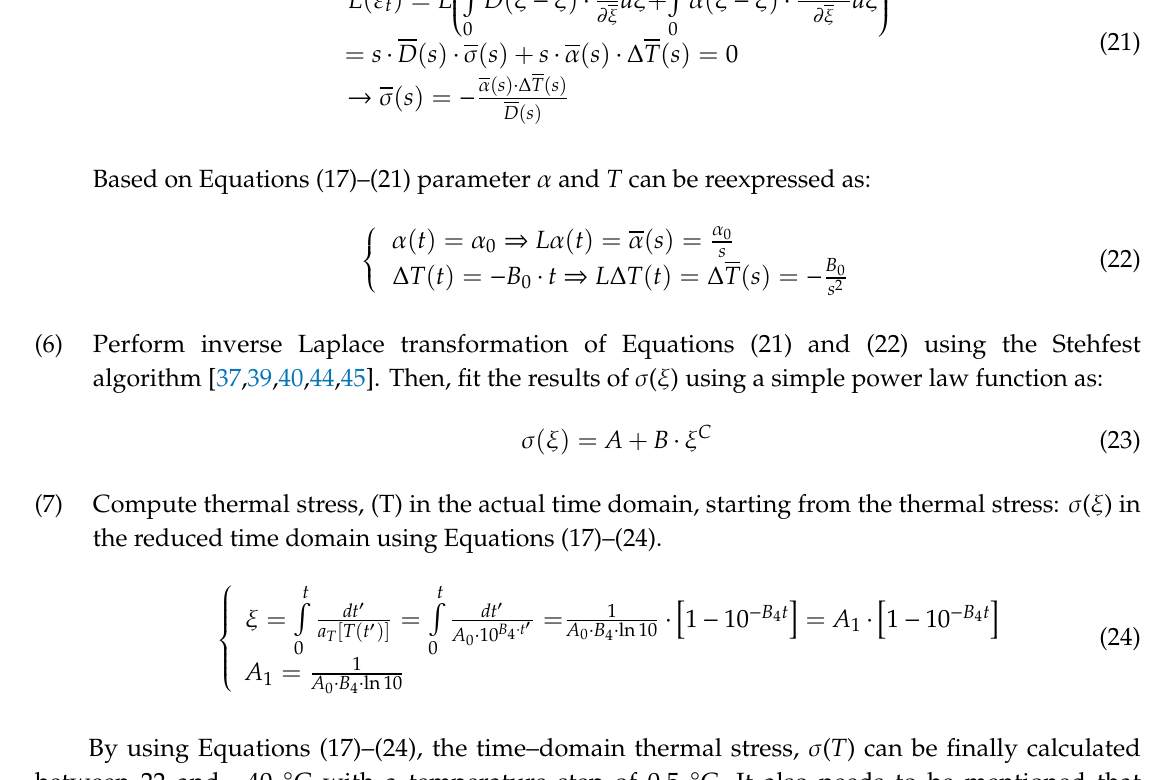
( a ) ( b ) Figure 6. m -value, m ( t ), at different testing time. ( a ) T = − 12 °C; ( b ) T = − 24 °C. As could be expected, the addition of RAP resulted in a higher creep stiffness and lower m - values due to the increasing degree of brittleness introduced by the recycled material. In the case of S ( t ), higher di ff erences were observed for each testing time at the lower testing temperature ( − 24 °C) when comparing the material designed with a RAP content of 25% and 40%. However, an opposite trend was exhibited from m ( t ) with more remarkable di ff erences at the higher temperature ( − 12 °C). Form a visual comparison, it also appears that, for the two distinct degrees of recycling (25% and 40%), a relatively moderate difference can be detected between SRRAP and DRRAP mixtures at both testing temperatures. It can be noted that the values of the coefficient of variation (also known as relative standard deviation) of the BBR measurements are in most cases below 10% and overall lower than a commonly accepted threshold of 15% for BBR tests on mixtures (Tables 3 and 4). This confirms the repeatability of this experimental method as already demonstrated in previous research [14,16,30,31]. To further evaluate the response of the material at low temperature, the results of the thermal stress calculation and critical cracking temperature are reported in the next sections of this paper.